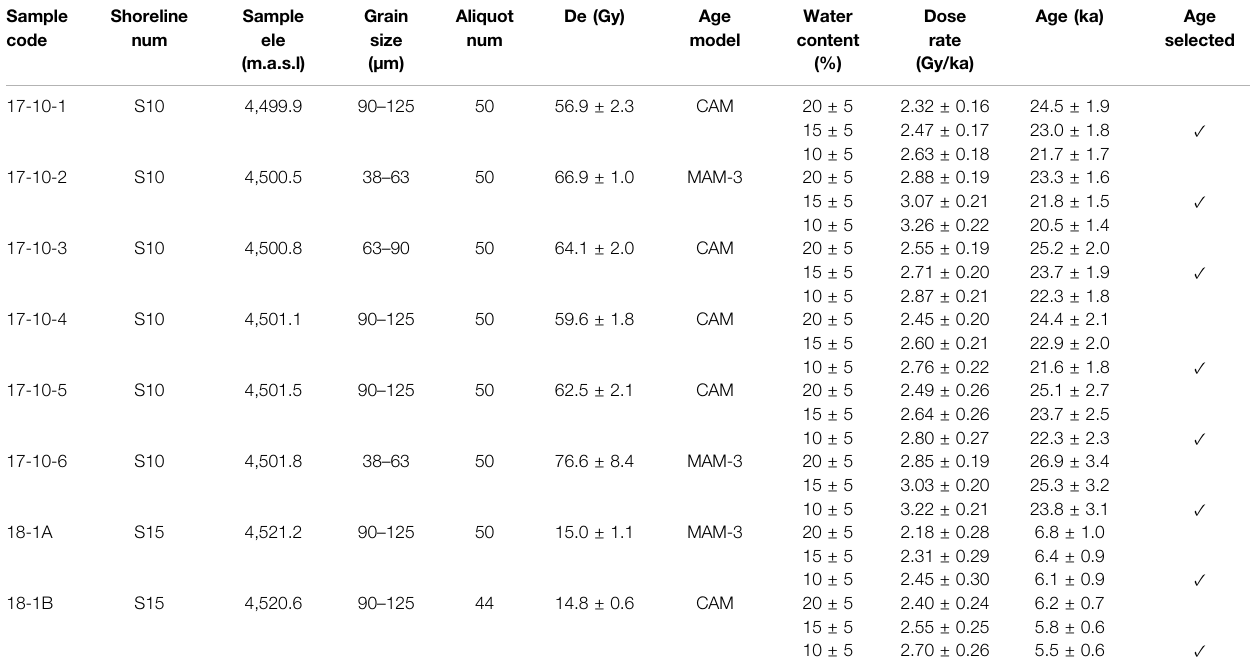
TABLE1| Summaryofshorelinecodes,elevations,aliquotnumbers,equivalentdoses,agemodels,watercontents,doserates,agesandselectedagesusedinthecontext. Uncertainties of individual quartz ages contain both random and systematic components. “ MAM-3 ” is the abbreviation of the 3-parameter minimum-age model, and “ CAM ” is the abbreviation of the central-age model (Arnold et al.,